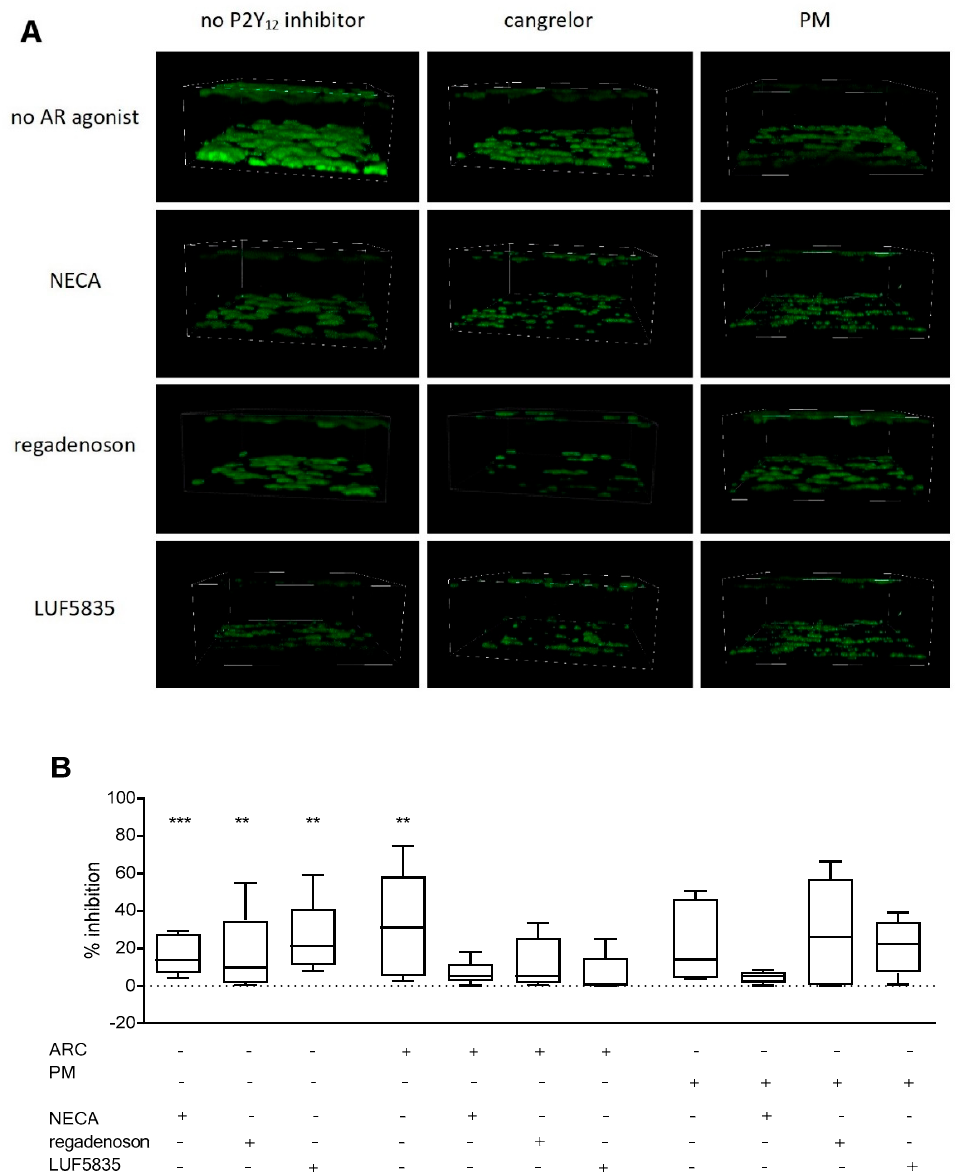
Figure 5. Anti-platelet effect of AR agonists and P2Y 12 antagonists on thrombus formation under flow conditions. Representative images ( A ) and clot formation inhibition rates (decrease of total clot volume) ( B ). Data are given as median, interquartile range, and minimum and maximum values ( n = 5). Changes in thrombus formation were analysed in whole blood in response to 60 dyne / cm